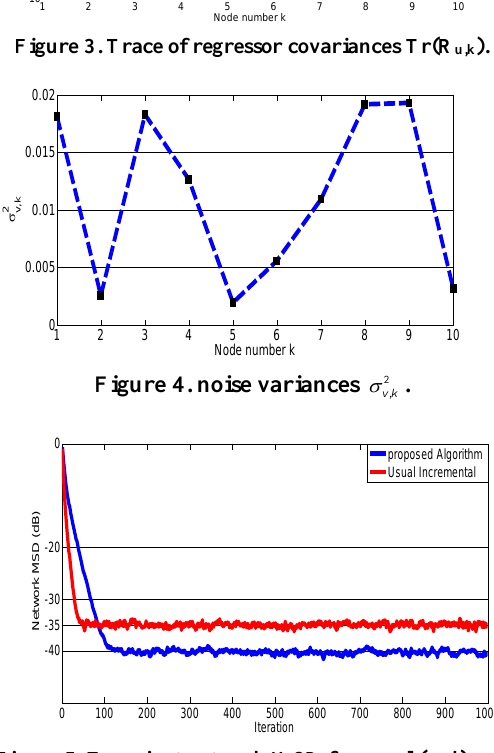
Figure 5. Transient network MSD for usual (red) and proposed (blue) incremental LMS.